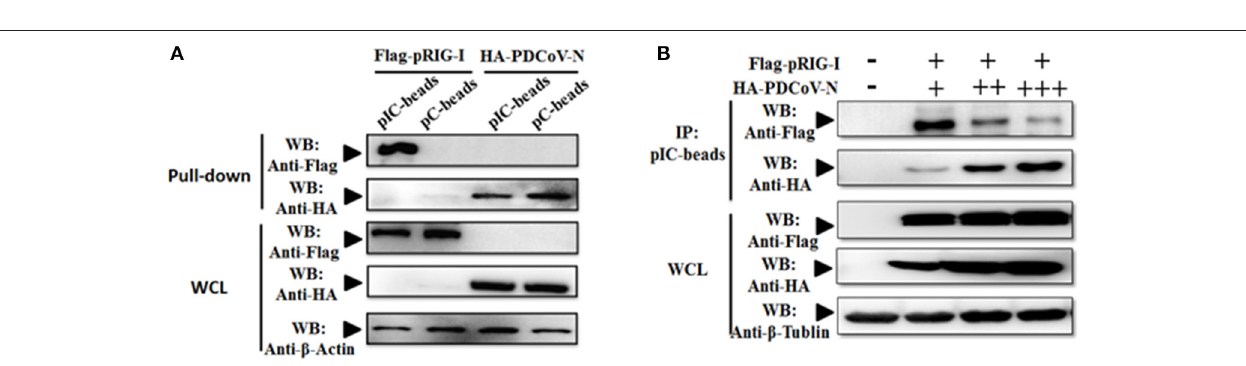
FIGURE 3 | PDCoV N interacts with both pRIG-I and pTRAF3. HEK293T cells were co-transfected with HA-tagged PDCoV-N and Flag-tagged pRIG-I (A–C) , Flag-tagged pMDA5 (A) , Flag-tagged TBK1 (B) , Flag-tagged pMAVS (B) , Flag-tagged pTRAF3 (B,D) or Flag-tagged pIRF3 (B) , respectively. After 28h of transfection, cells were lysed for co-immunoprecipitation (Co-IP) assay with anti-Flag (IP: Anti-Flag) or anti-HA (IP: Anti-HA) affinity gel. The WCLs and immunoprecipitants were detected by western blot with anti-Flag, anti-HA or anti- β -action antibody. (E) PK-15 cells were cotransfected with HA-tagged PDCoV-N and Flag-tagged empty plasmid as control or Flag-tagged pRIG-I, respectively. At 24h after transfection, cells were fixed for IFA to detect the PDCoV-N (green) and pRIG-I (Red) with anti-HA and anti-Flag antibodies, respectively. 4 ′ , 6-diamidino-2-phenylindole (DAPI, blue) stained the cell nuclei. Fluorescent images were acquired with a confocal laser scanning microscope (scar bar: 10 µ m). (F) Schematic representation of PDCoV N protein fragments used for Co-IP analyses (up). HEK293T cells were cotransfected with Flag-tagged pRIG-I and HA-tagged full-length or truncated fragments of the PDCoV N protein. After 28h of transfection, cells were lysed for Co-IP assay with anti-Flag affinity gel. The WCLs and immunoprecipitants were detected by western blot with anti-Flag, anti-HA, or anti- β -action antibody. (G) PK-15 cells were cotransfected with pGL3-pIFN- β , pRL-TL, and pcDNA3.1-Flag-pRIG-I alone or together with PDCoV N truncated fragments, respectively. Dual-luciferase assays were performed at 24h post transfection. All the experiments were independently performed three times. ** p < 0.01.